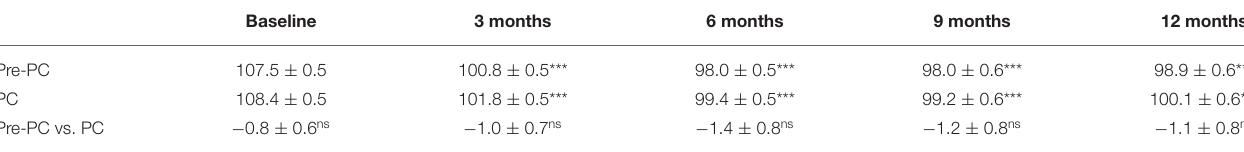
TABLE 2 | Weight from baseline to 1 year in Pre-PC and PC.